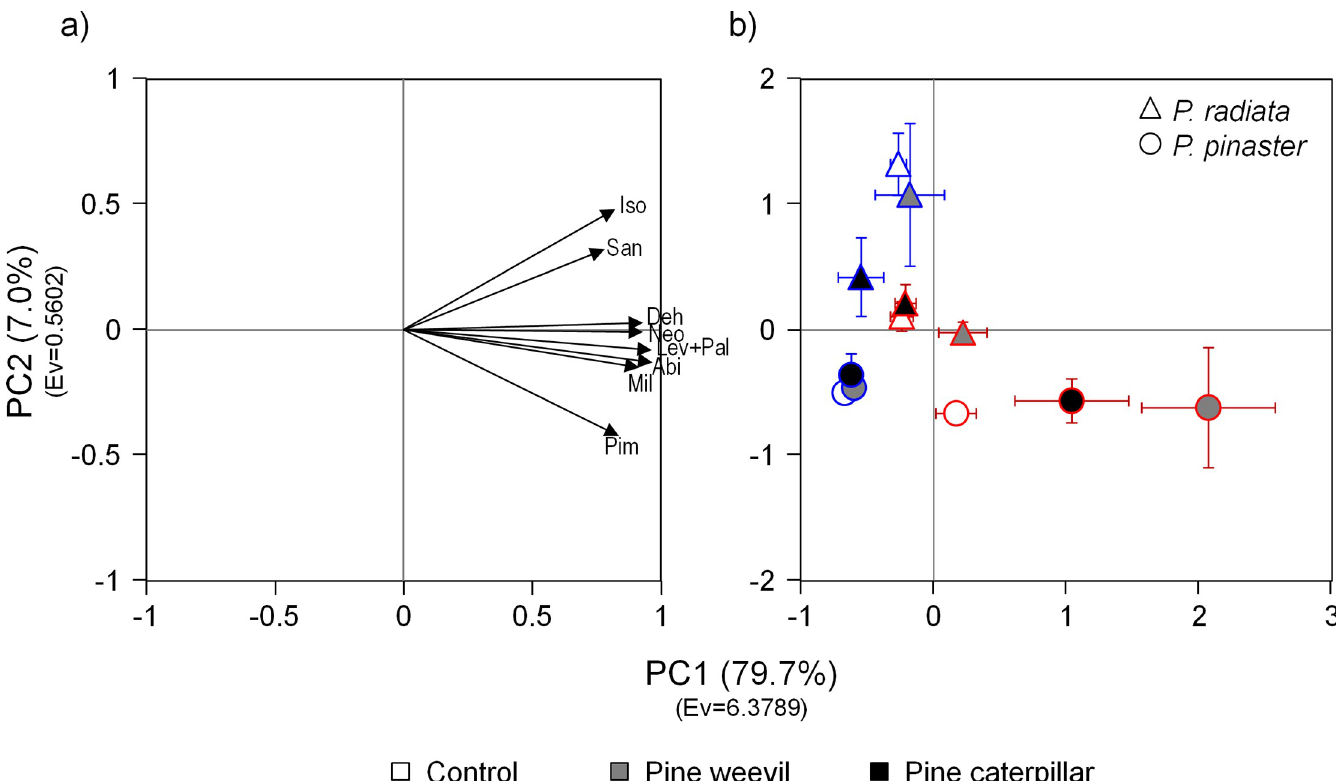
Fig 3. Principal component analysis of the constitutive concentration of the main resin acids and their induced responses in the stem phloem and needles after herbivory by two insect chewers. a) Graphical representation of the variable loadings for each component; b) chemical profile and concentration of resin acids in the multivariate space depicted by pine species, herbivory treatments and plant tissues (coloured symbol borders and error bars: red = stem phloem, blue = needles). Each symbol and error bars represent the mean of PC1 and PC2 and their standard errors, respectively, for each combination of pine species, herbivory treatments, and plant tissues (N = 9–10 plants). Variance explained (in %) and eigenvalue (Ev) of each component are indicated in brackets. Abi = abietic, Deh = dehydroabietic, Iso = isopimaric, Lev+Pal = levopimaric + palustric, Neo = neoabietic, Pim = pimaric, San = sandaracopimaric, Mil =